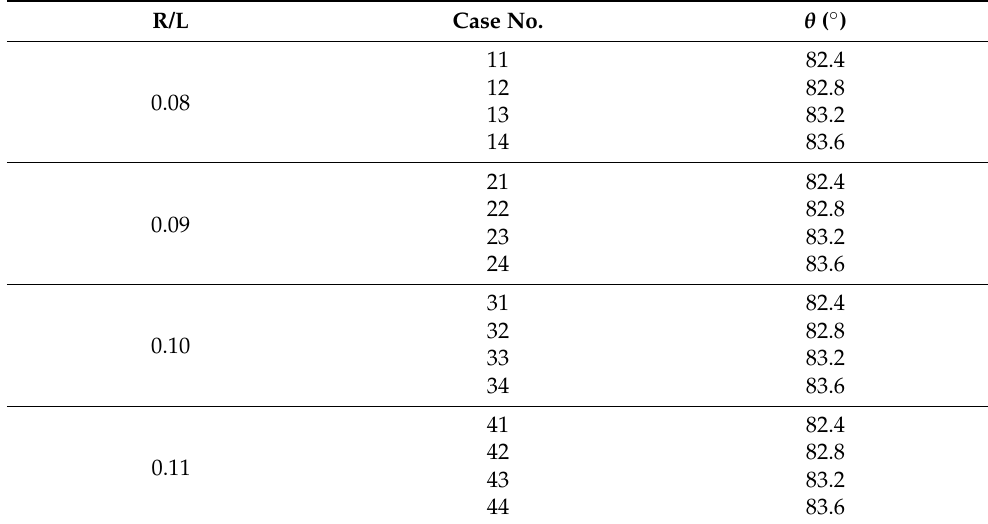
Figure 2. ( a ) Detailed SPB drawing: ( b ) front view of SPB, ( c ) half-length model, and ( d ) quarter model. Table 1. FEA scenario according to corrugation radius and fillet angle.